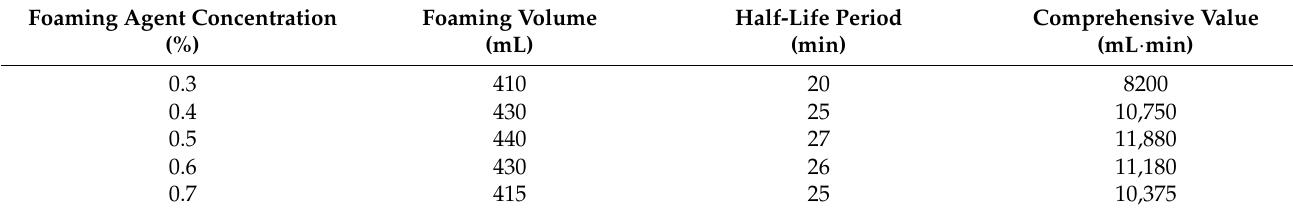
Table 4. Preferred foaming agent concentration.